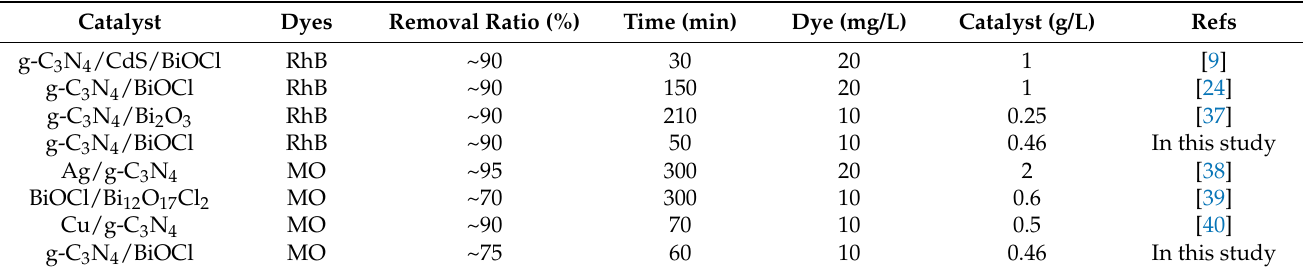
Table 2. Comparison of catalytic activity of g-C 3 N 4 nanoball/BiOCl nanotube heterojunction with some reported catalysts in the degradation of organic dyes.